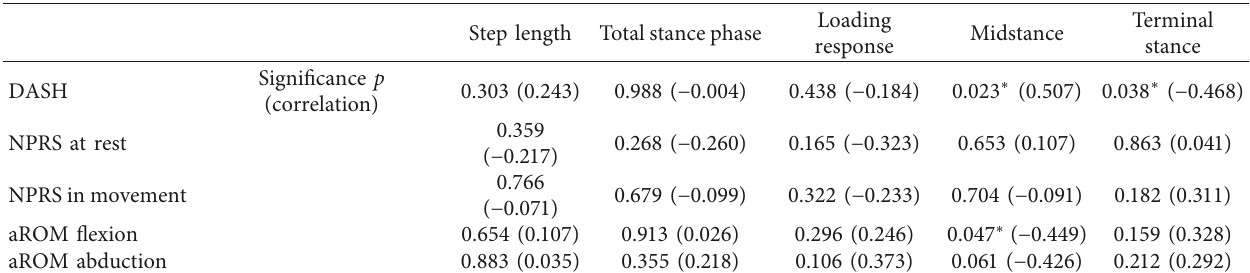
Figure 2: Shoulder group: correlation determination between DASH and duration of the midstance and the terminal stance phase and duration of the midstance phase and the aROM of shoulder flexion and abduction ( ∗ asterisks indicate significance). (a) Duration of midstance versus DASH ( p � 0.023 ∗ ). (b) Duration of terminal stance versus DASH ( p � 0.038 ∗ ). (c) Duration of midstance versus aROM flexion ( p = 0.047 ∗ ). (d) Duration of midstance versus aROM abduction ( p = 0.061). Table 2: Cross tabulation of gait and secondary outcome